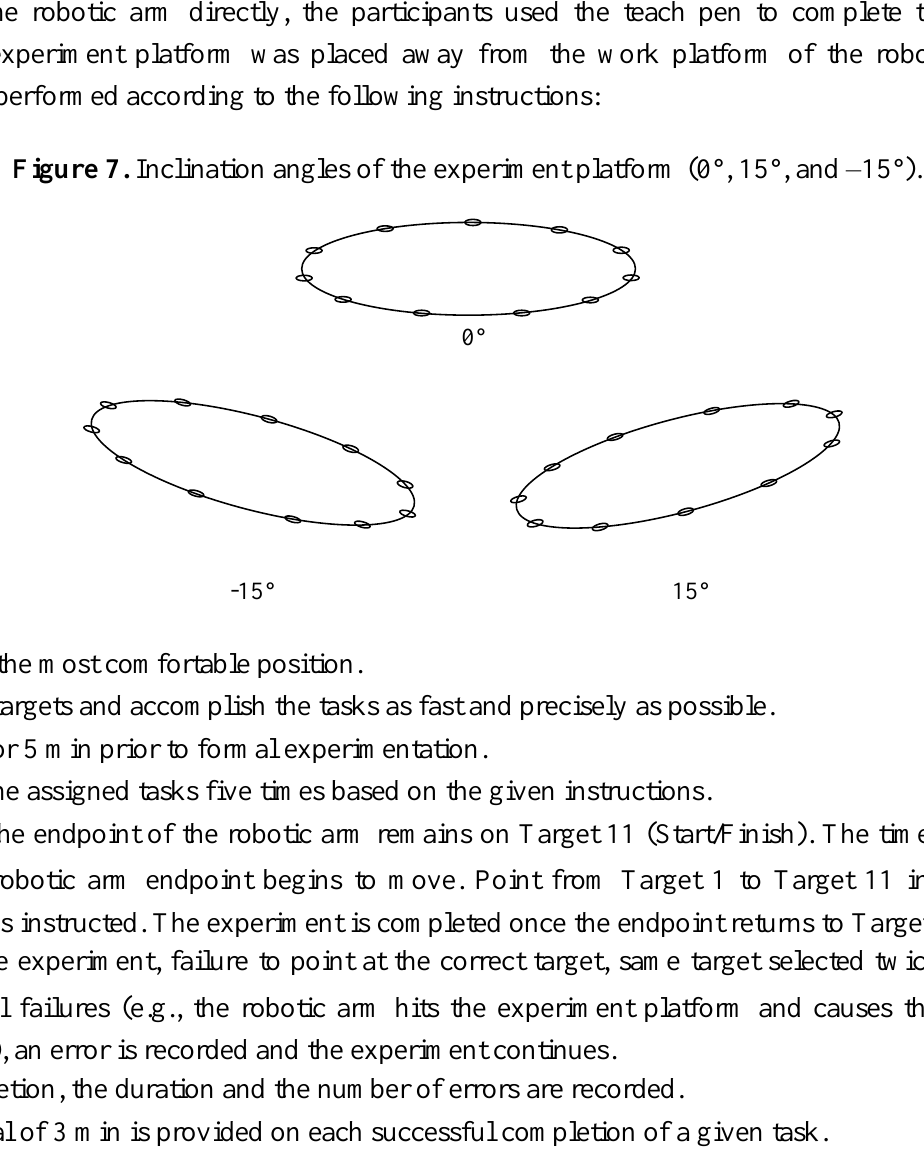
Figure 7. Inclination angles of the experiment platform (0°, 15°, and –15°).